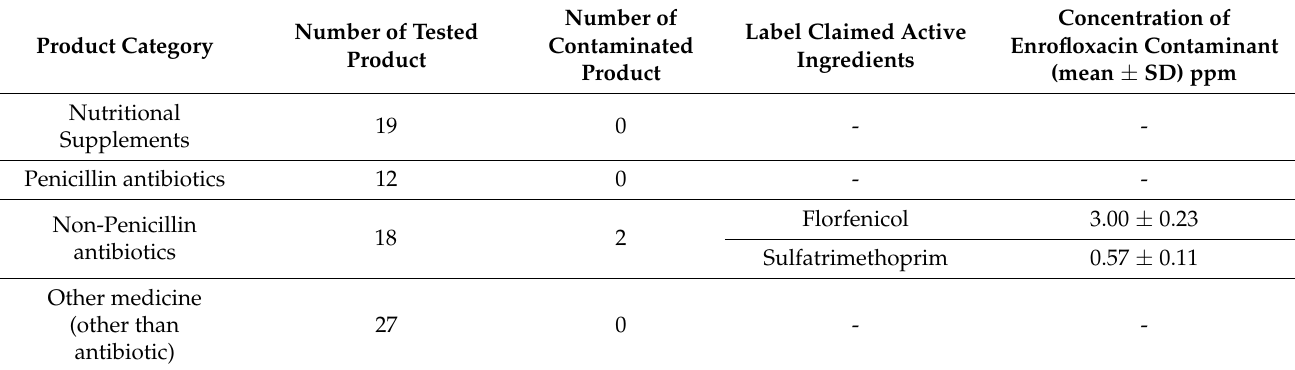
Table 3. Results of enrofloxacin cross-contamination in the widely used veterinary medicinal and nutritional products in Korea except the NPJ those claim to have no